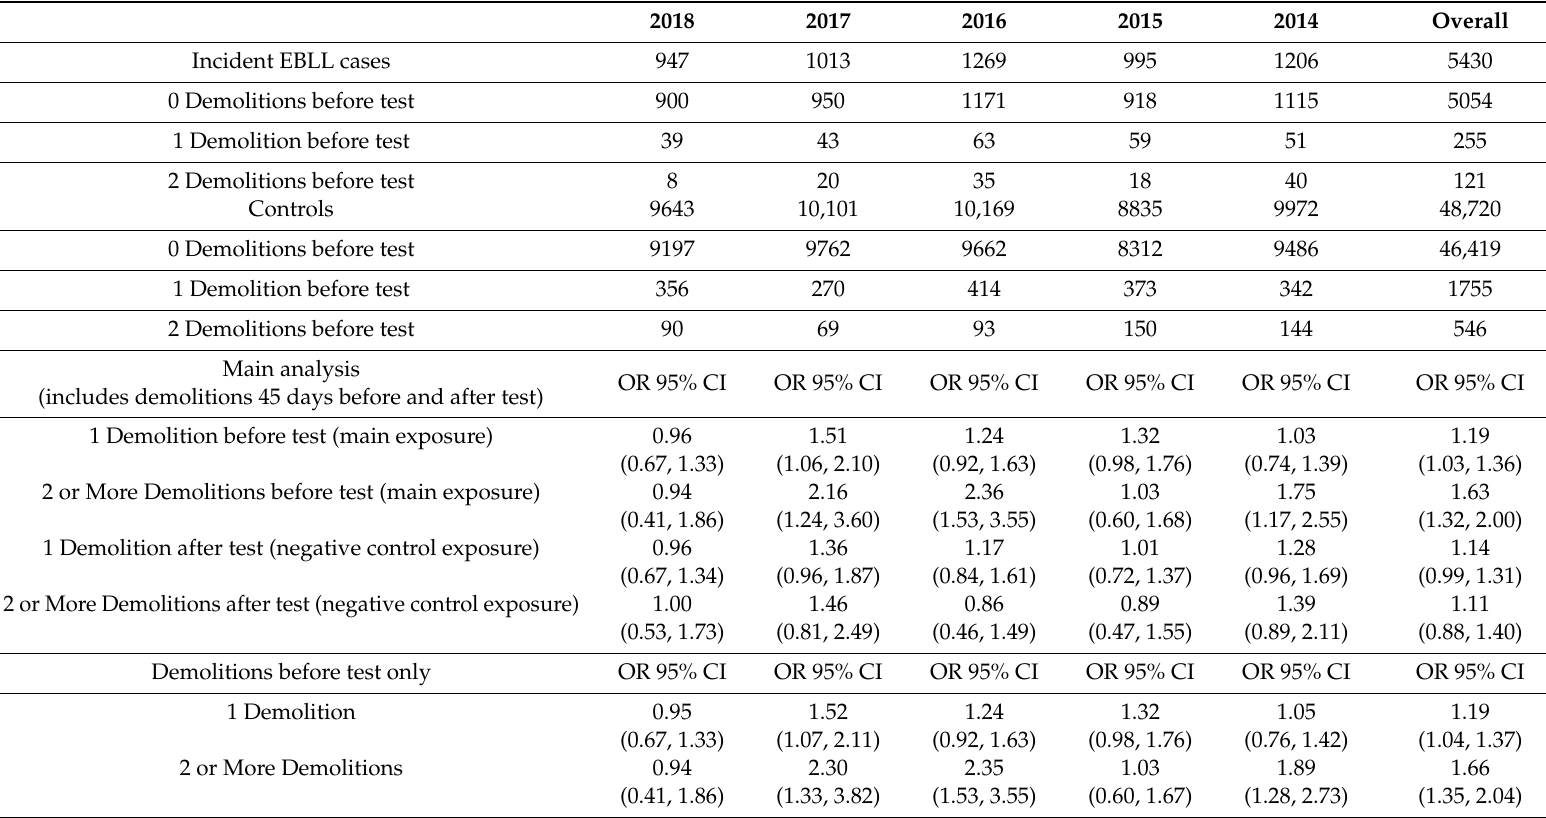
Table 4. Results of a case-control analysis of the association between demolitions and incident elevated blood lead levels among children < 6 years old, by calendar year, Detroit, 2014–2018 (N = 54,150 observations, 5430